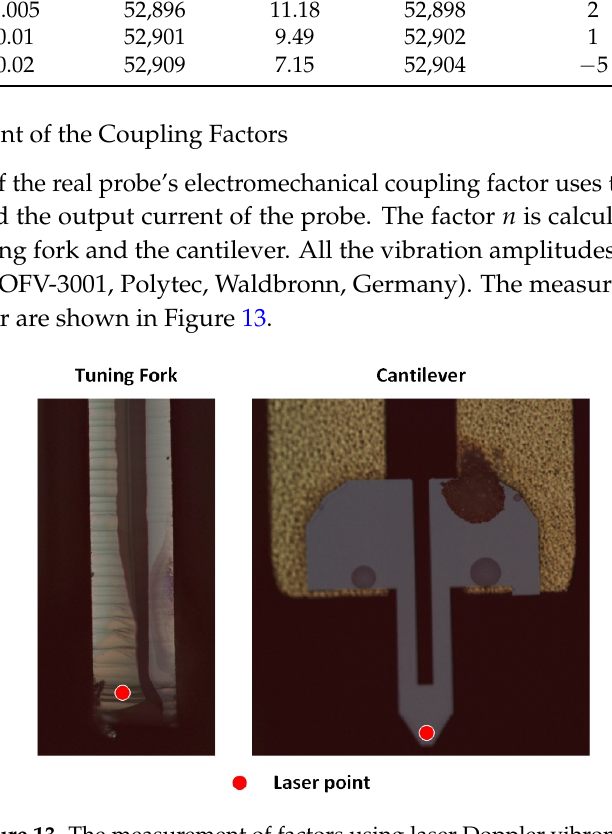
Figure 13. The measurement of factors using laser Doppler vibrometer.